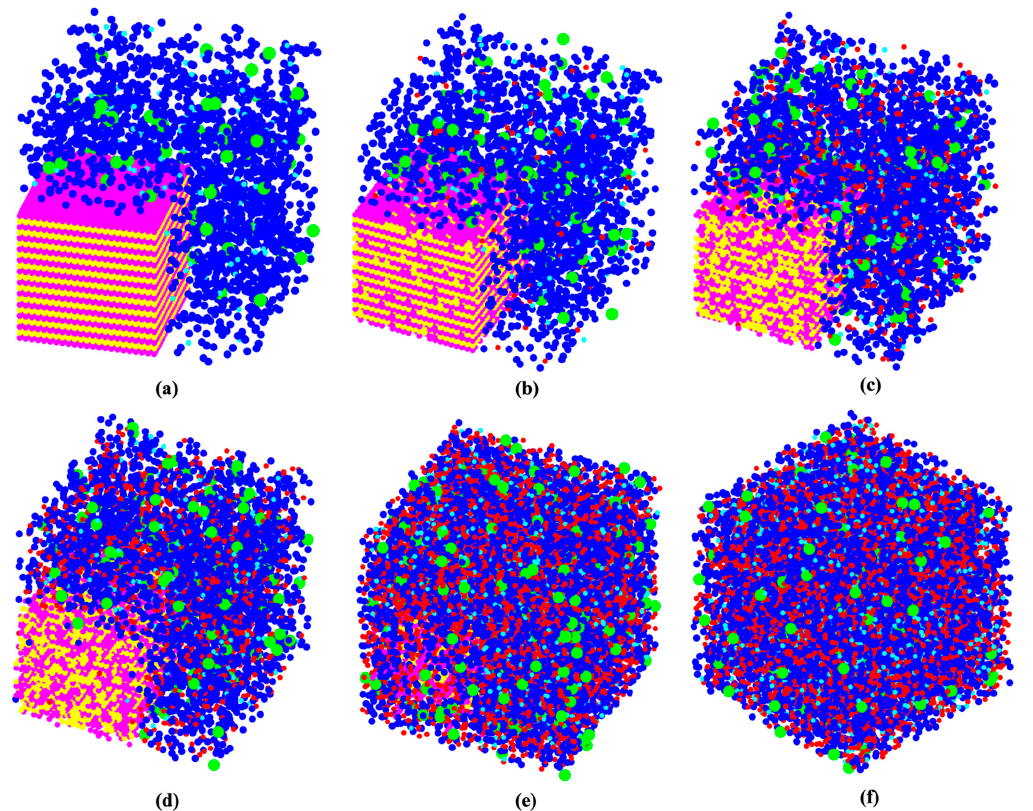
Figure 2. ( a – f ) The evolution of the six three-dimensional snapshots of the structures and cluster formations for the geopolymer extracted at a certain number of iterations of 0, 1000, 5000, 10,000, 100,000, and 7,000,000, respectively. The different monomer building units (coarse grained particles) are depicted with the following color codes: Si(OH) 4 are given in cyan; SiO(OH) 3 − · Na + · 3H 2 O, in blue; SiO 2 (OH) 2 − · 2Na + · 6H 2 O, in green; Al(OH) 4 − Na + , in red. A close-up view of Figure 2a, representing the solid metakaolinite phase (aluminate as yellow and silicate as magenta) is given in the Appendix A (Figure A1).